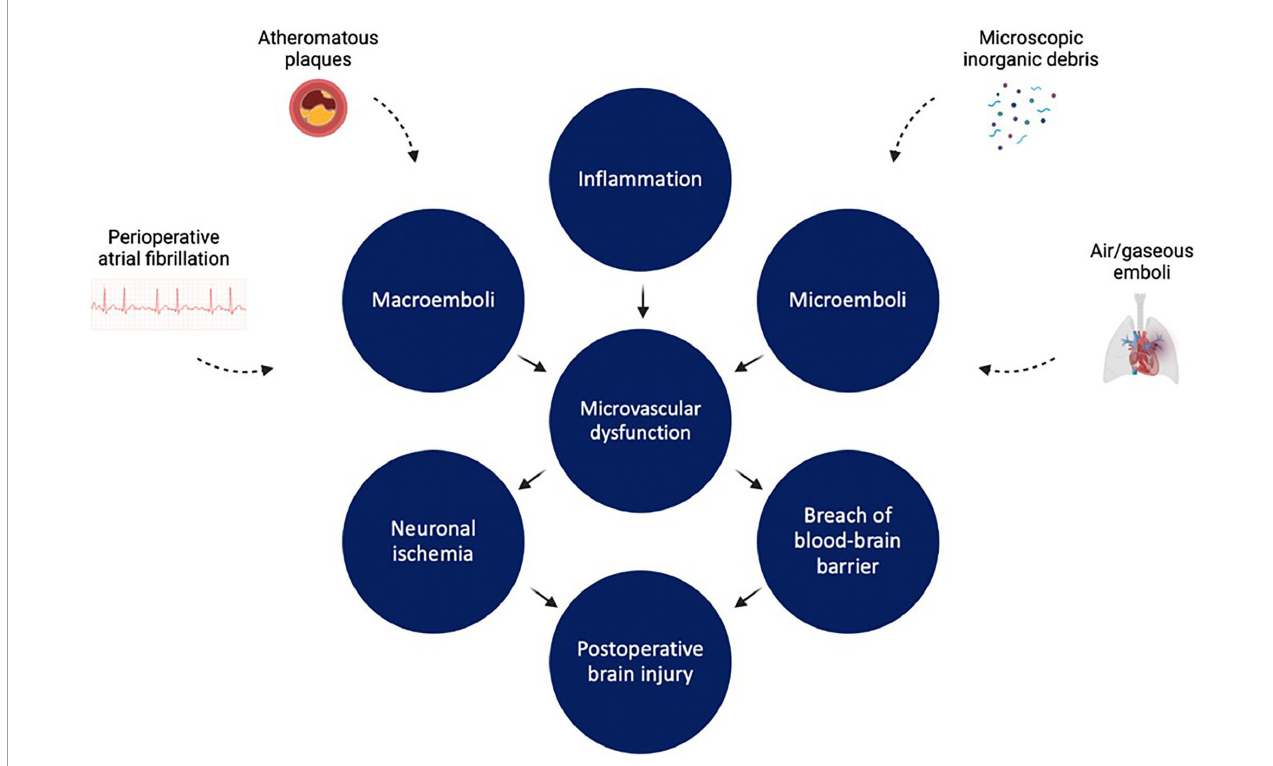
FIGURE4 Factors leading to cerebrovascular dysfunction during and after cardiopulmonary bypass. Inflammation, microemboli, and macroemboli all lead to microvascular dysfunction. This in turn leads to neuronal ischemia and disruption of blood brain barrier integrity, resulting in brain injury. Figure created using